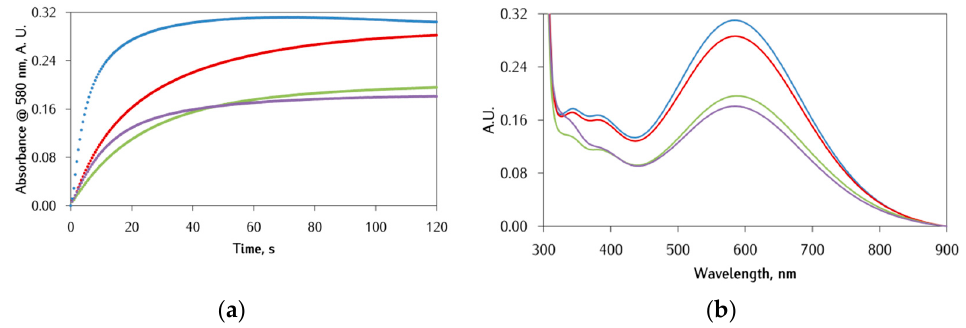
Figure 3. ( a ) Kinetic traces ( λ max = 580 nm) and ( b ) UV-Vis spectra of DA-Fe II (2:1) interaction as a function of peptide concentration in 10 mM Mops bu ff er pH 7.0, 37 °C, Fe II 0.1 mM, DA 0.2 mM (blue), and 2 equiv. of peptide (Ac- α S 119–132 : red, Ac- α S p S 119–132 : green, Ac- α S p Y p S 119–132 : purple). The phosphorylated peptides Ac- α S p S 119–132 and Ac- α S p Y p S 119–132 have a stronger im-